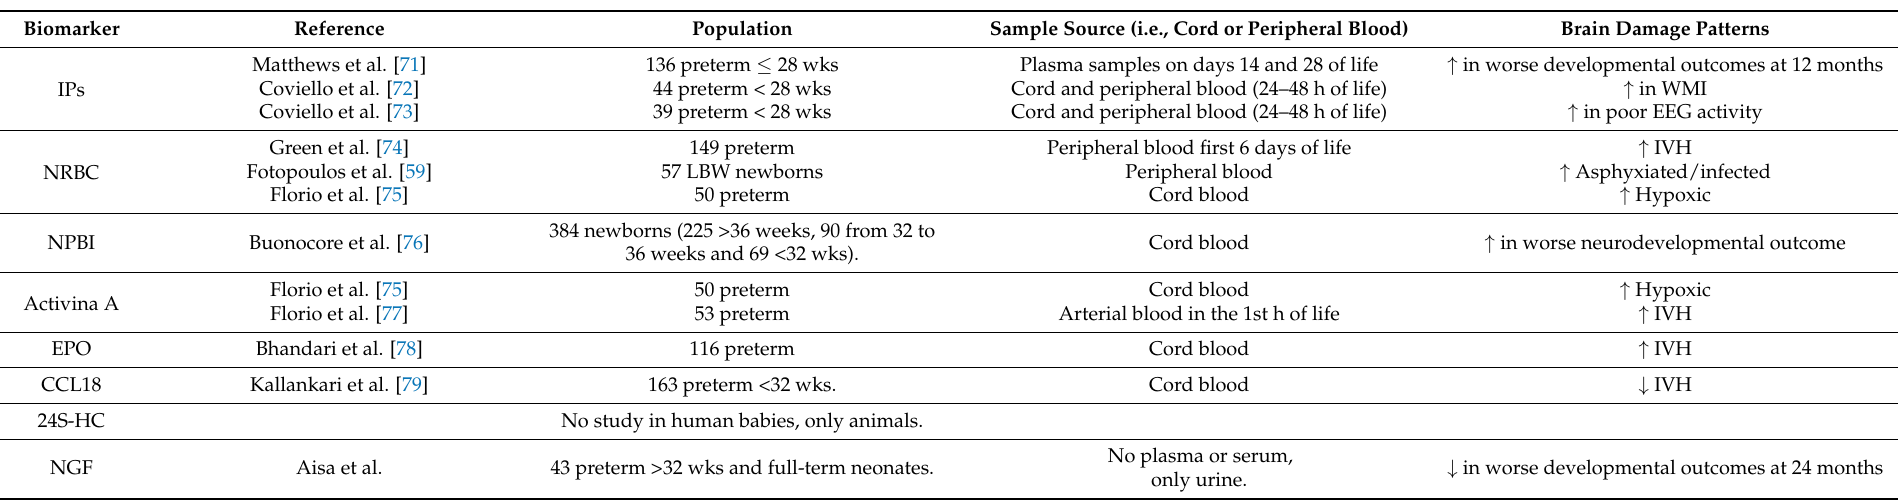
Table legend: DPP4 (dipeptidylpeptidase 4); HIE (hypoxic ischemic encephalopathy); NSE (neuron-specific enolase); S-100B (acidic calcium-binding protein); IUGR (intrauterine growth restriction); IVH (intraventricular hemorrhage); SGA (small for gestational age); AGA (adequate for gestational age); CP (cerebral palsy); IPs (F2-isoprostanes); WMI (white